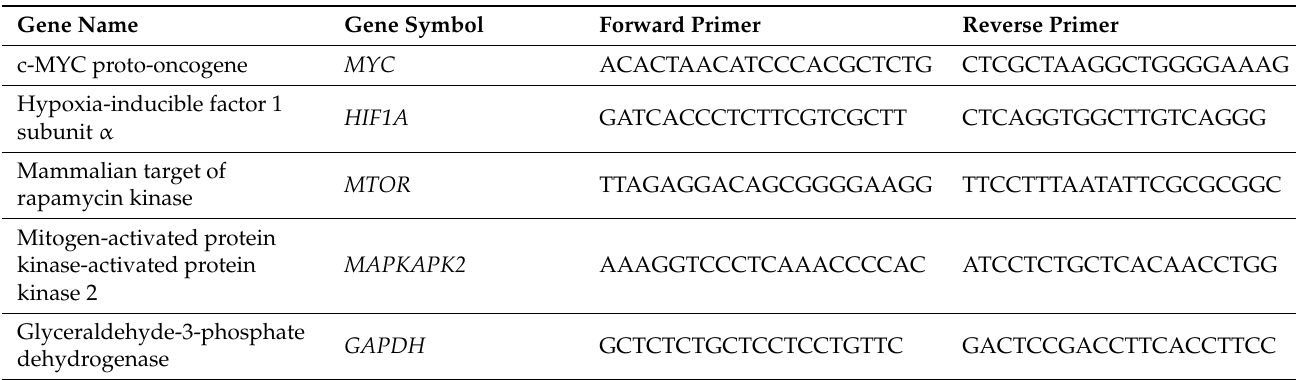
Table 2. Sequences of qPCR